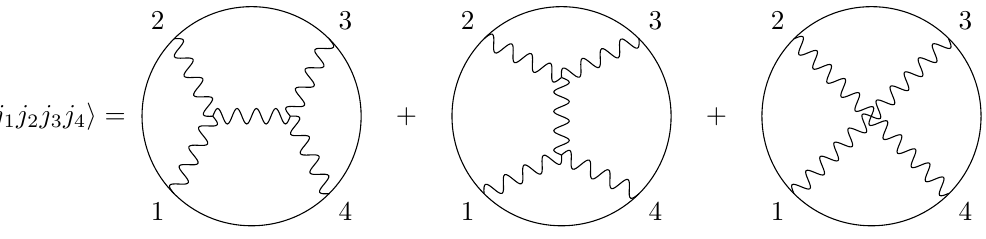
Figure 2 . Witten diagrams for the color-ordered 4-point AdS